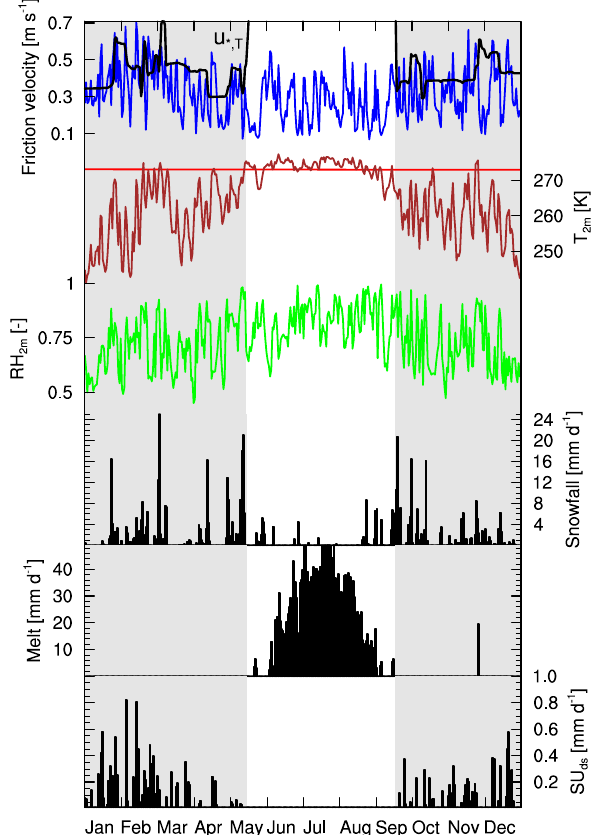
Fig. 9. Modeled annual cycle (2005) at S6 (67 ◦ 5 0 N, 49 ◦ 23 0 W) of daily mean friction velocity (blue) and its threshold (black, see text), 2m temperature (the freezing point is illustrated by the hori- zontal red line) and relative humidity, daily accumulated snowfall, snowmelt and drifting snow sublimation. The grey areas represent the drifting snow season (see text).